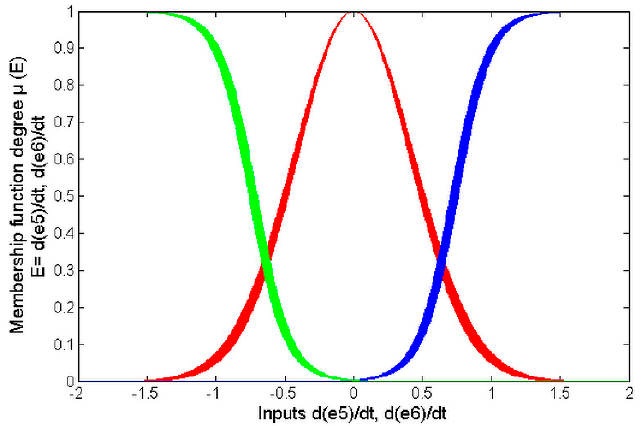
Figure 4. Membership functions of the interval T2 adaptive fuzzy system (IT2-AFS) ˆ f 1 .